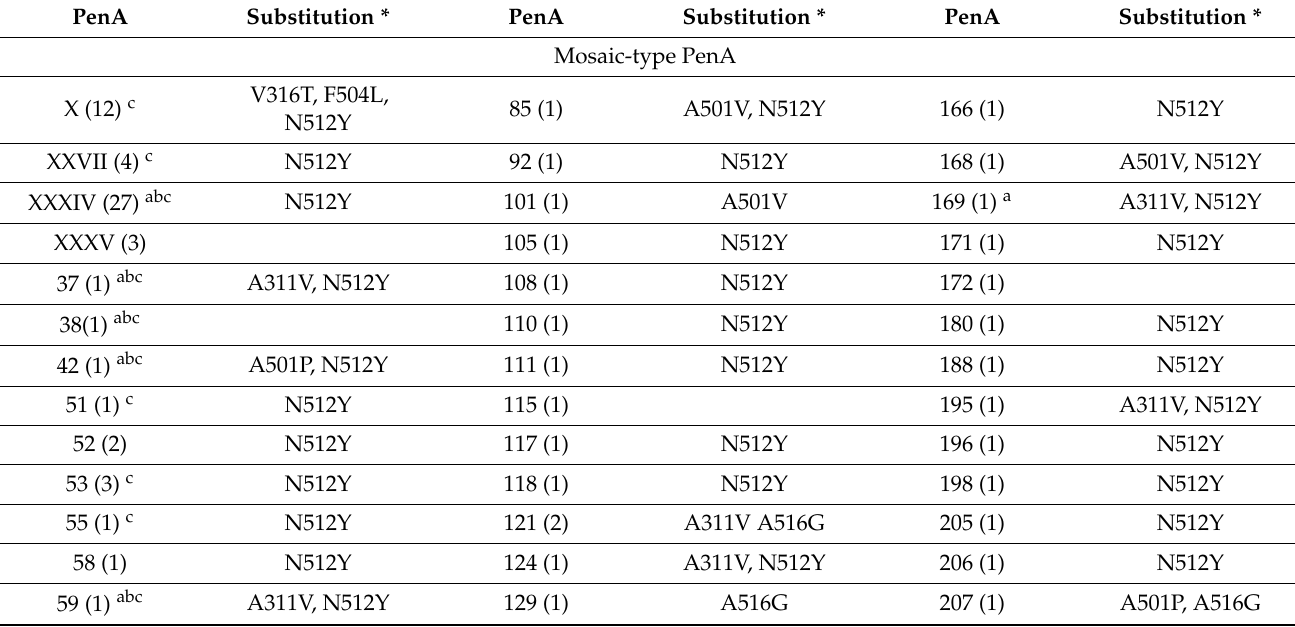
Table 4. Mosaic- and semimosaic-type